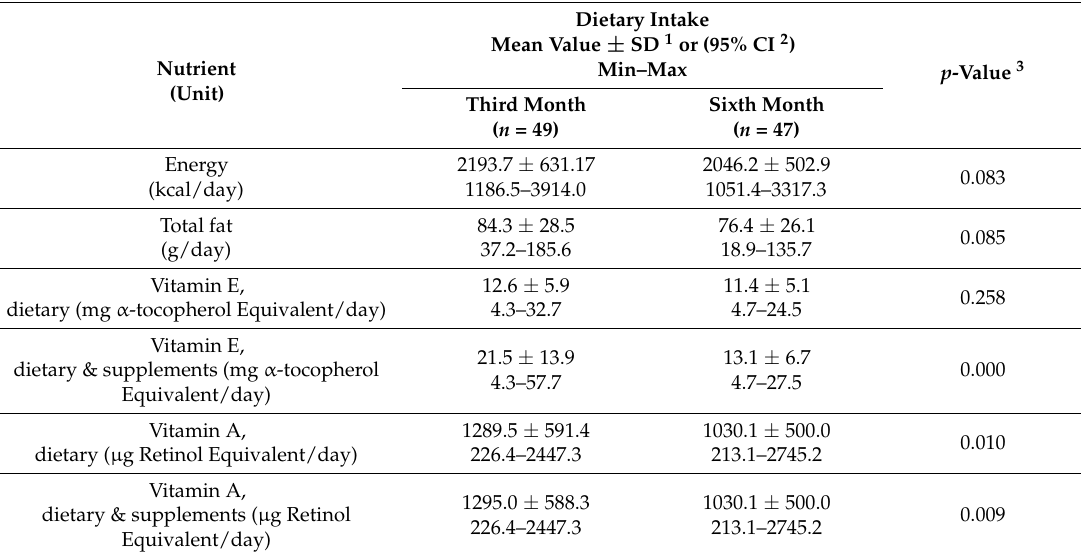
Table 3. Energy value and selected nutrients and carotenoid intake by participants at the third and sixth month of